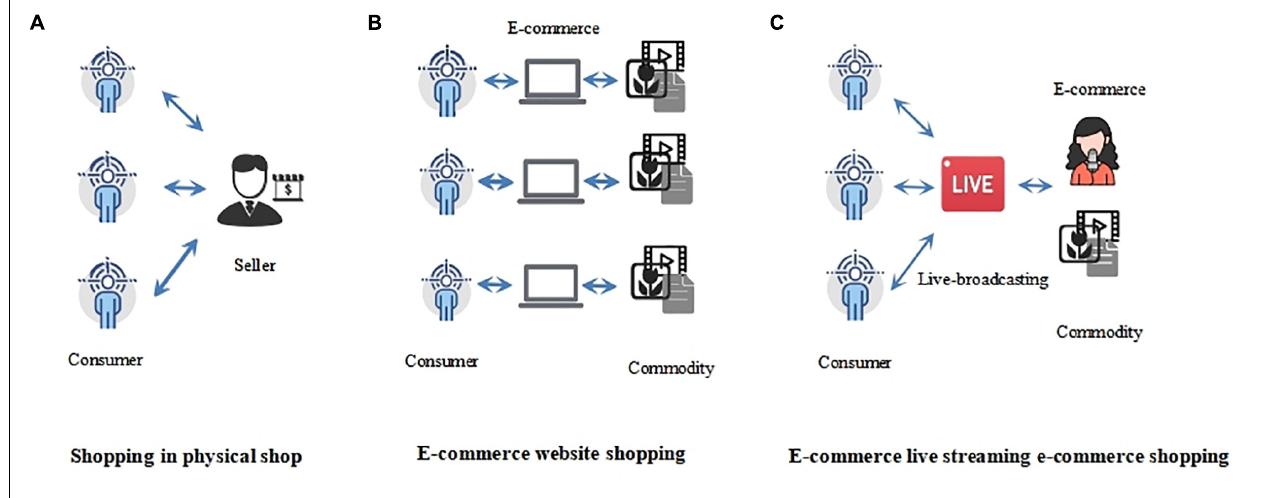
FIGURE 1 | Three types of shopping